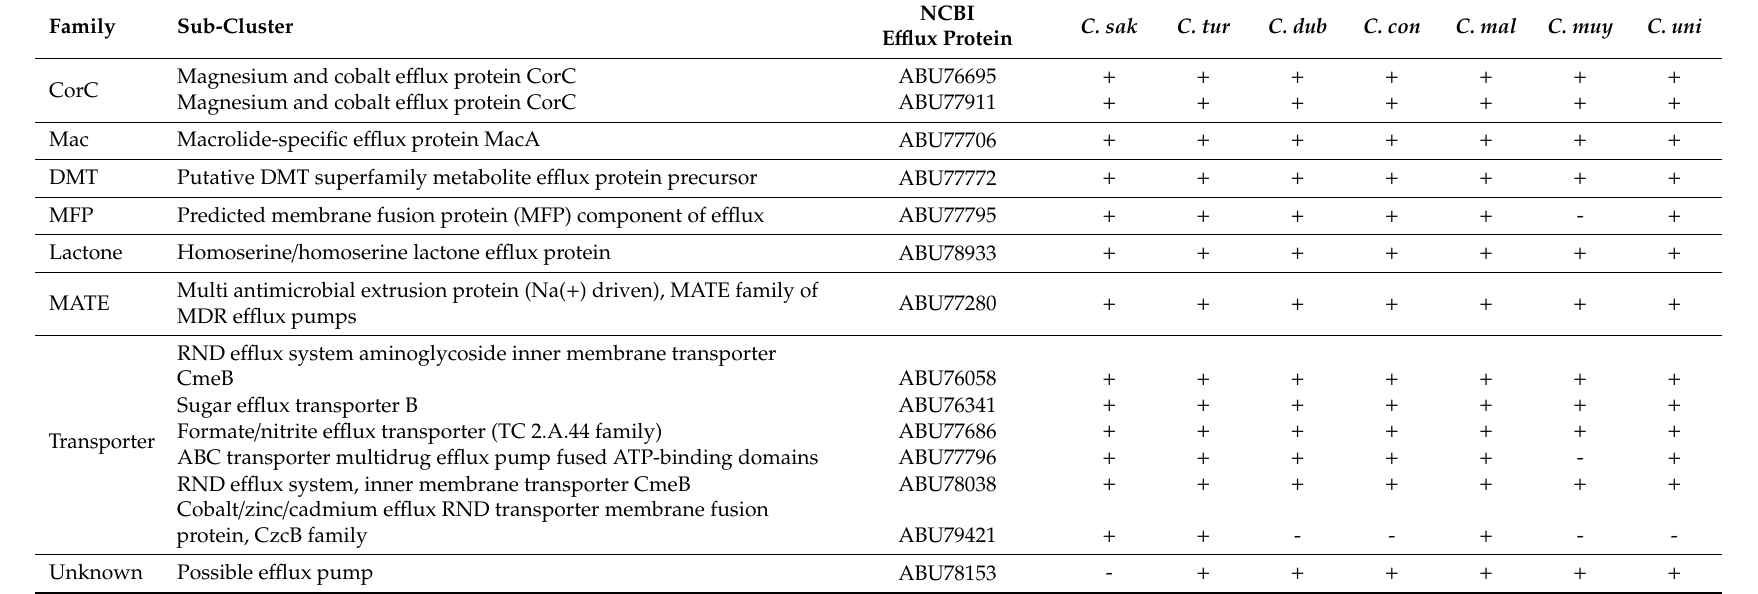
Table 3. Prevalence and distribution and NCBI protein annotations of e ffl ux pump associated genes among the seven Cronobacter species as described on the pan-genomic Cronobacter microarray a